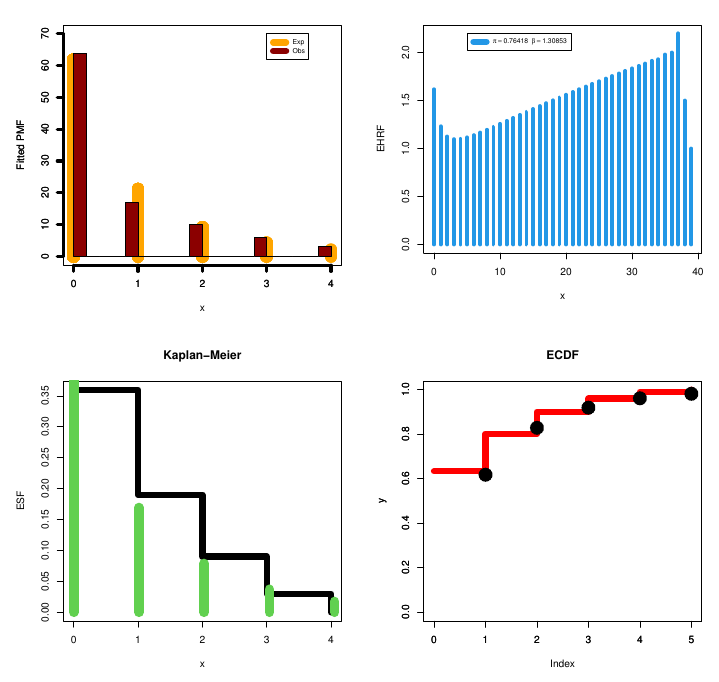
Figure 6 – The fitted PMF, EHRF, ESF and ECDF for the carious teeth